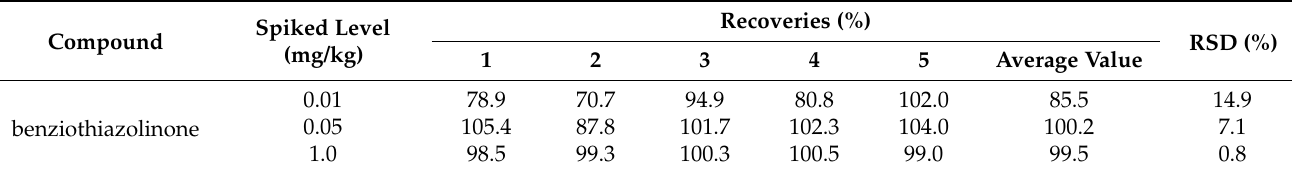
Table 1. Recoveries of benziothiazolinone in